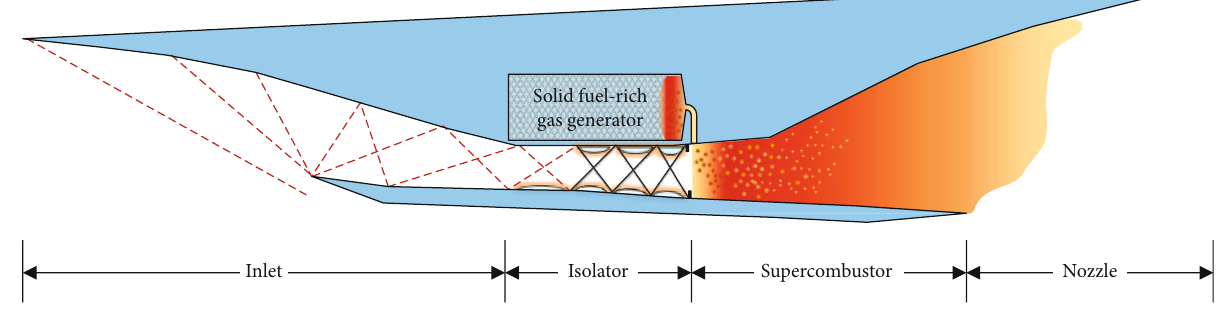
Figure 1: Schematic of a solid